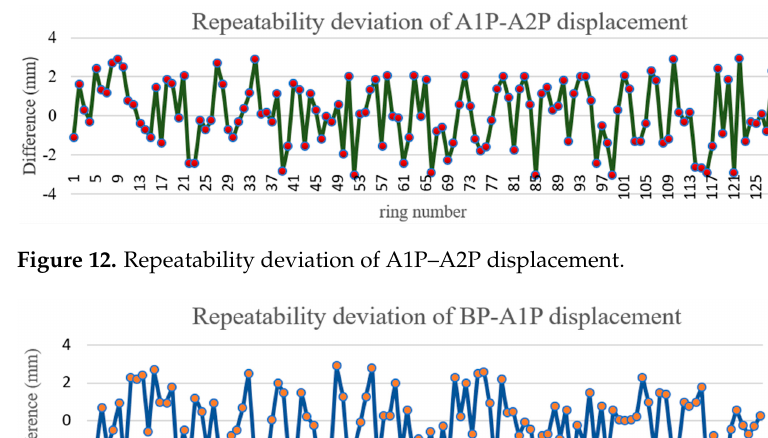
Figure 14. Repeatability deviation of KP–BP displacement.